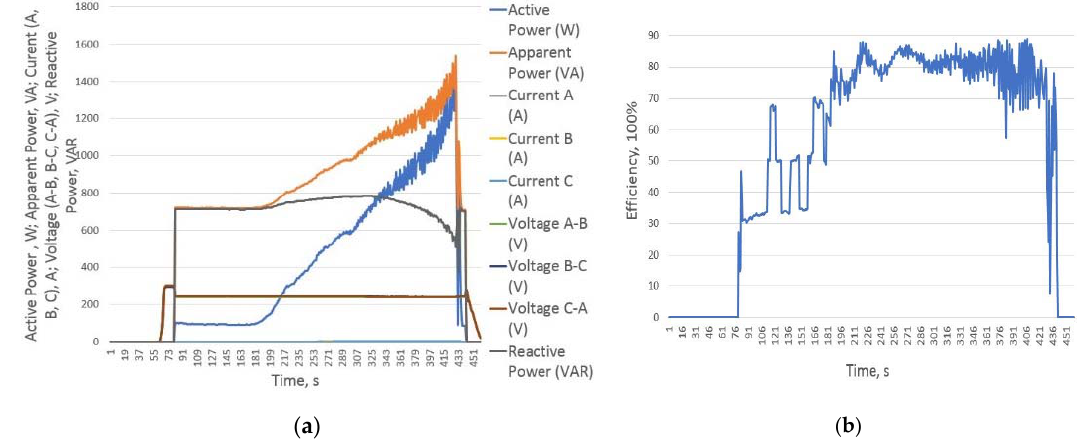
Figure 8. The results of the PMSM efficiency determination experiment with a reduced voltage of 240 V applied during the experiment. ( a ) Electrical PMSM input parameters; ( b ) efficiency curve.